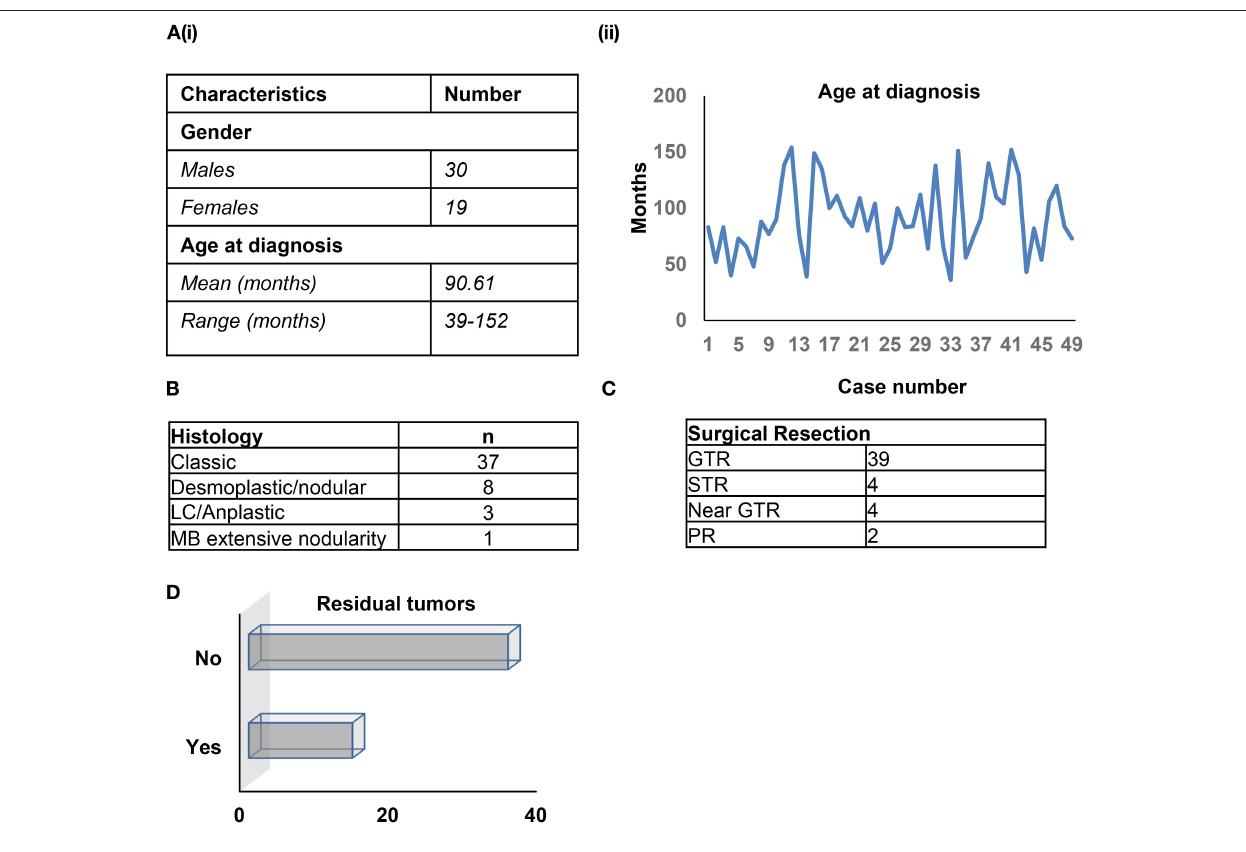
FIGURE 1 | (A–D) Patient